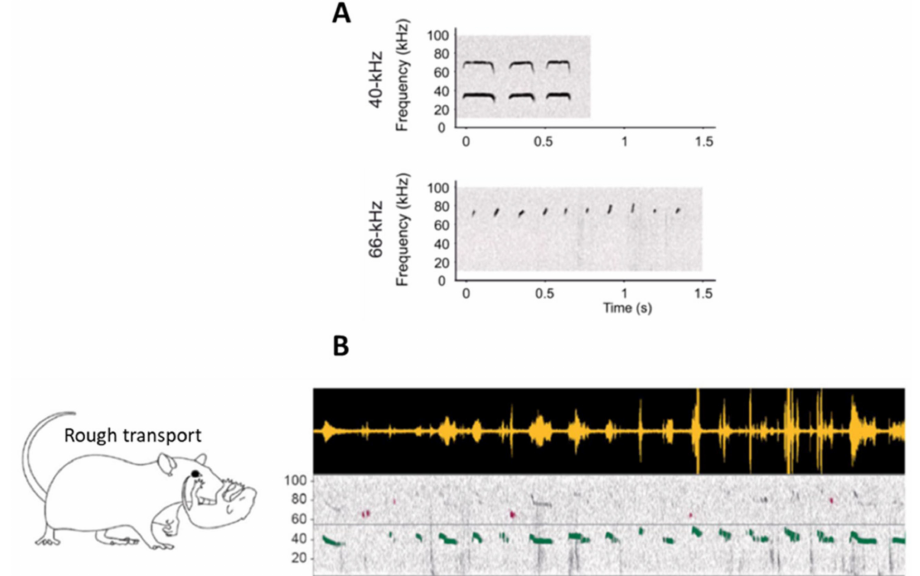
Figure 1. ( A ) Examples of individual sonograms of the two types of infant USV at 40 kHz and 66 kHz. ( B ) Examples of infant USV emitted in a naturalistic situation, here during rough transport by the mother. The top panel represents the raw USV signal, and the bottom panel represents the associated spectrogram (frequency in kHz as a function of time). The light horizontal gray line on the spectrogram represents the separation between 40-kHz (green) and 66-kHz USV (purple). Rough transport of the pup by the dam specifically enhanced the emission of 40-kHz USV (adapted from Boulanger-Bertolus et al.